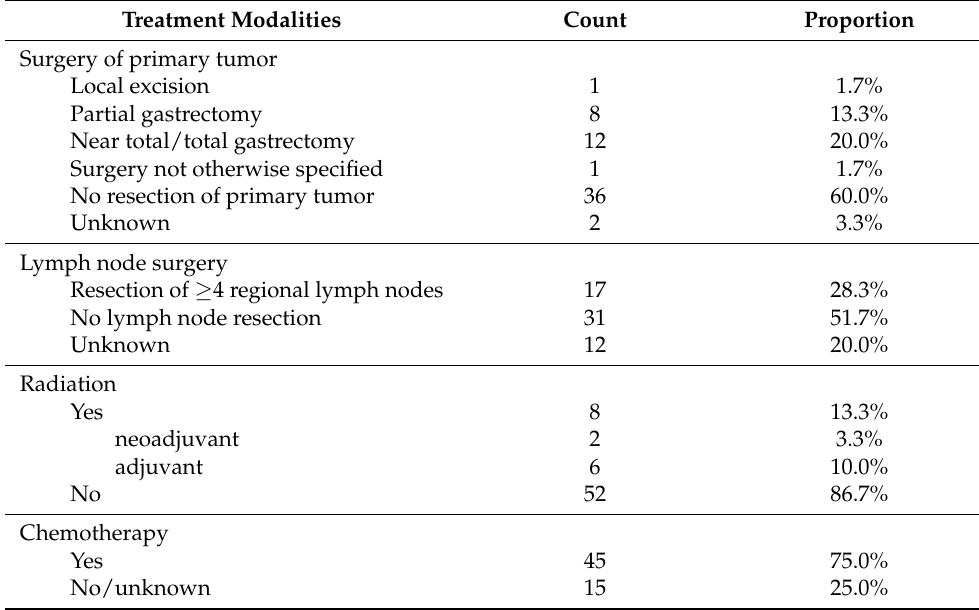
Table 2. Treatment characteristics of gastric carcinoma in patients aged 0–19 years registered in the Surveillance, Epidemiology, and End Results Program 2000–2018.